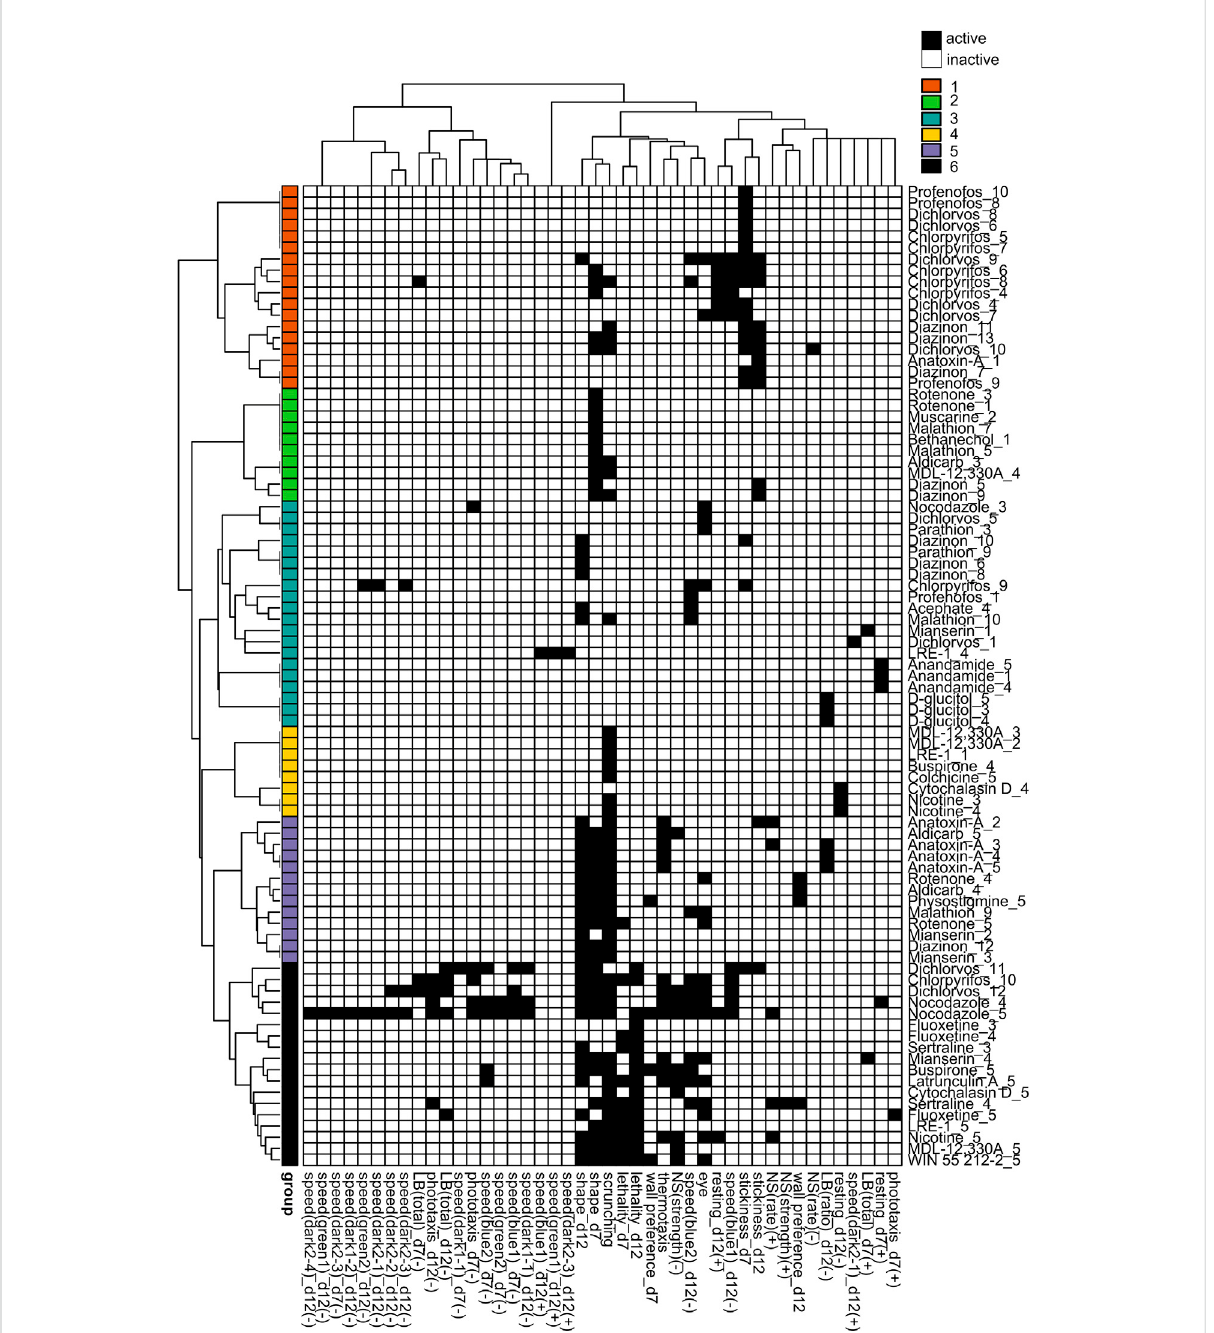
FIGURE 6 Hierarchical clustering of regenerating phenotypic barcodes. Active outcome measures for each chemical concentration are shown in black. Outcome measures that can have effects in both directions are separated into either the positive (+) or negative (-) direction. Only active chemical concentrationsandoutcomemeasuresareshown.Numbersinchemicalnamesrefertotherespectivetestconcentration,with1asthelowesttested concentration,seeTable1.Hierarchicalclustering wasperformedusingbinary distance andWard ’ smethod.Sixdistinctclusterswereidenti fi ed with similar phenotypic pro fi les: Cluster 1: effects on stickiness, Cluster 2: abnormal body shapes, Cluster 3: hits in miscellaneous endpoints, Cluster 4: primarily scrunching defects, Cluster 5: effects in scrunching and body shape with the addition of other outcomes, Cluster 6: lethal/systemic